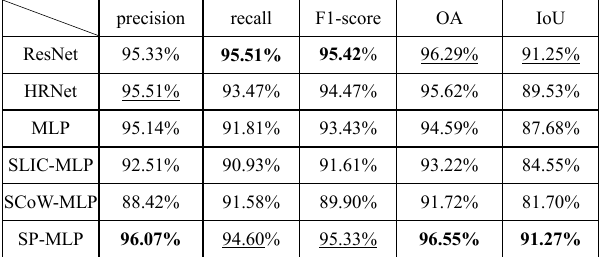
Table 3. Vegetation detection and evaluation results of ISPRS image dataset. The best results are bolded and the second-best results are